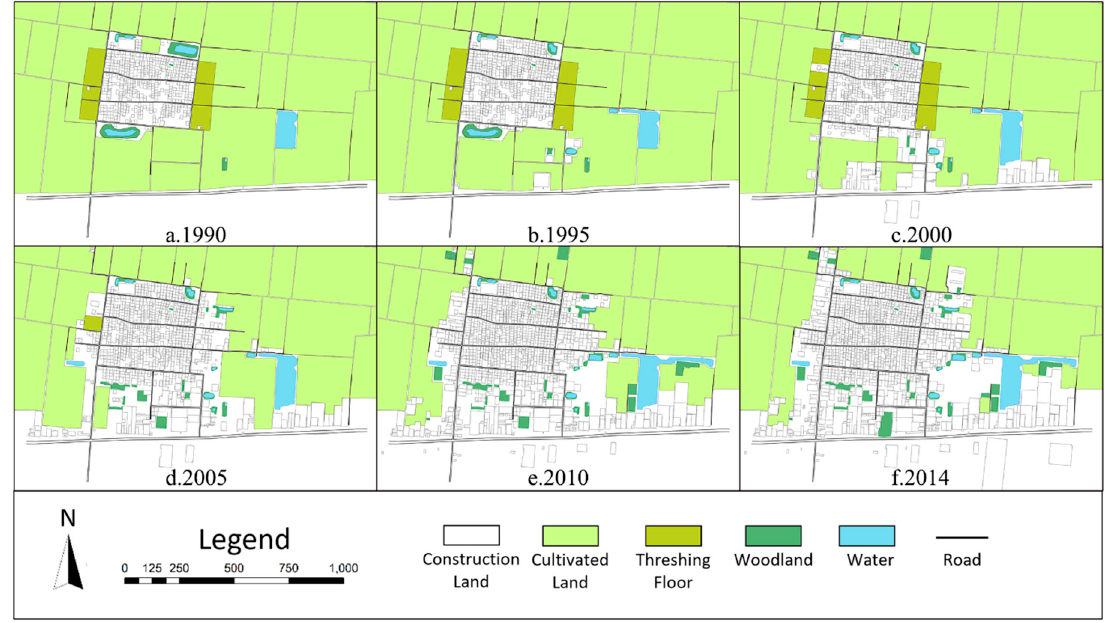
Figure 2. Spatial evolution of the construction land in Fengzhuang from 1990 to 2014.